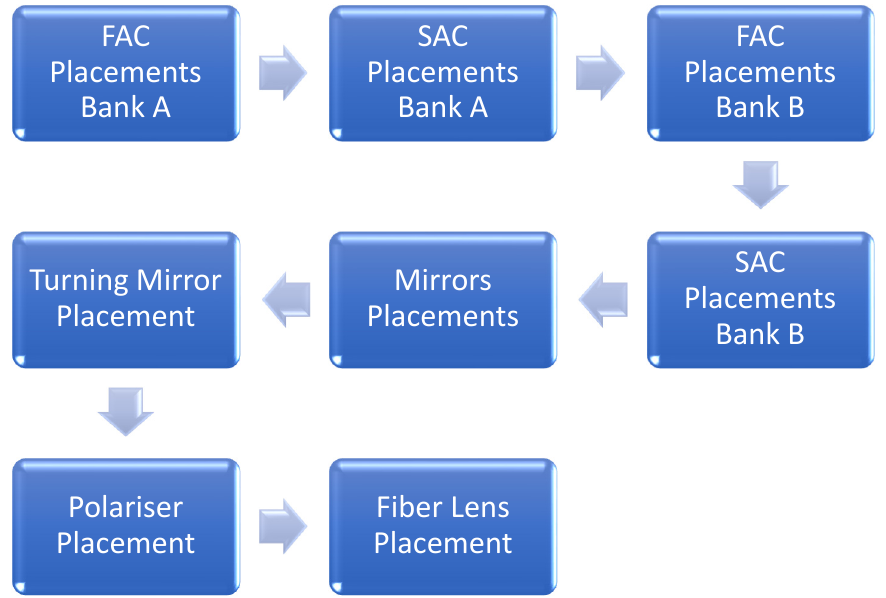
Figure 2. Assembly process from start to finish of the d-serie laser module.